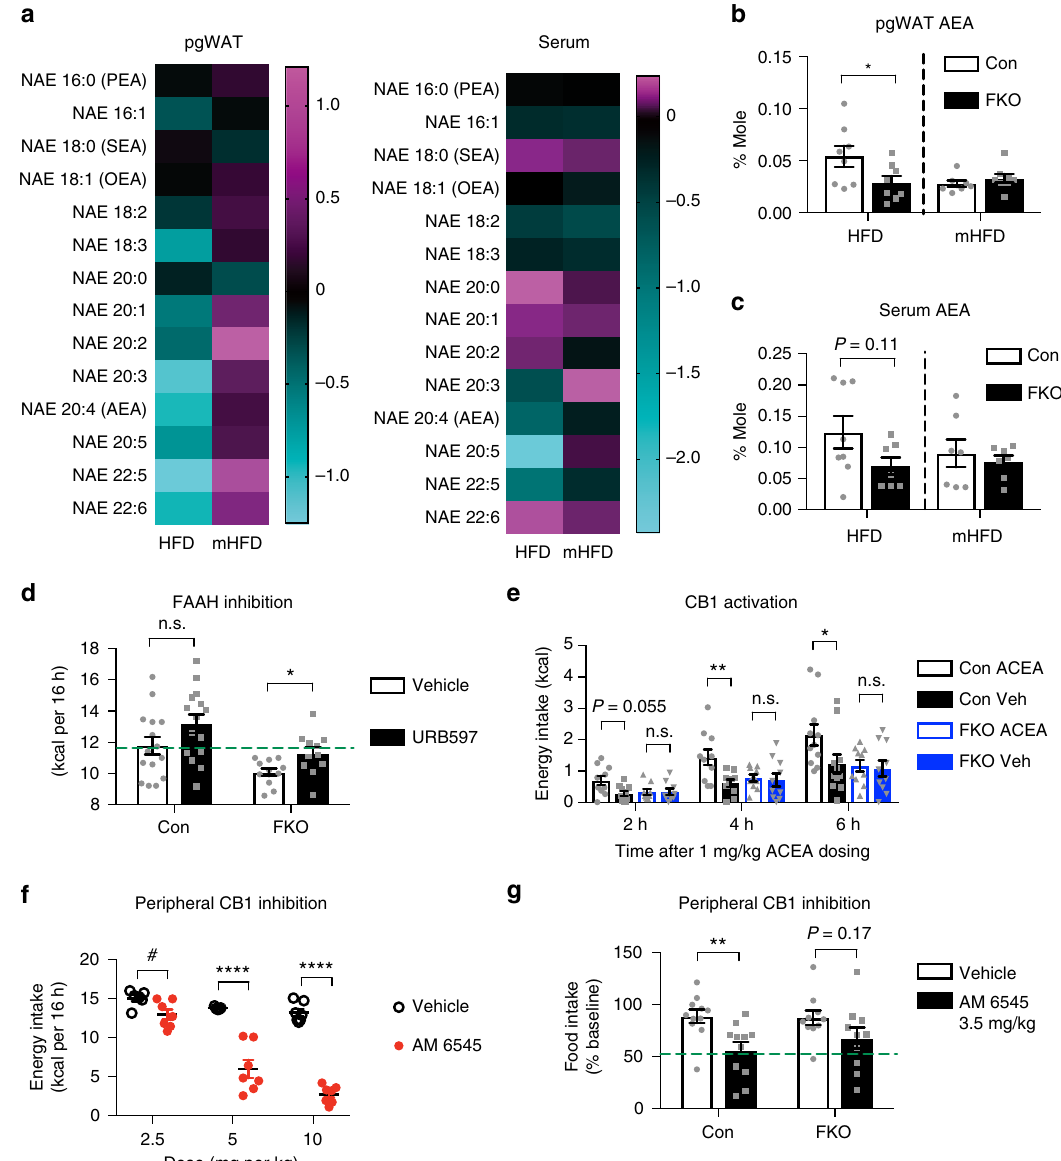
Fig. 5 Adipose tissue endocannabinoid metabolism mediates the appetite-inducing effect of OGT. a Heatmap of N -acylethanolamine (NAE) pro fi les in adipose tissue (pgWAT) and serum from mice ( n = 8 per group) fed HFD or mHFD for 14 – 15 weeks. Data has been processed to follow Gaussian distribution. Each box represents the log 2 ratio of FKO/WT. b , c Levels of AEA in adipose tissue ( b ) and serum ( c ) from mice described above. d Energy intake of mice ( n = 15 or 11) fed HFD for 10 – 13 weeks and dosed with FAAH inhibitor URB597 (0.5 mg/kg). n.s. not signi fi cant, * P < 0.05, multiple t-tests adjusted by the Holm – Sidak method. e Energy intake of mice ( n = 11 or 10) fed HFD for 12 – 14 weeks and dosed with CB1 agonist ACEA (1 mg/kg). Mice were dosed at 8:30 – 9:00 a.m., and measured at indicated time points. n.s. not signi fi cant, * P < 0.05, ** P < 0.01, repeat-measure post hoc Sidak ’ s tests. f Energy intake of mice ( n = 7 per group) fed HFD for 13 weeks dosed with peripheral CB1 receptor blocker AM 6545 as indicated. Data were presented as mean ± s.e.m. n.s. not signi fi cant, * P < 0.05, ** P < 0.01, **** P < 0.0001, post hoc Sidak ’ s tests, or # P < 0.05, two-tailed Student ’ s t-test. g Food intake (% pre-injection baseline) of mice ( n = 11 or 10) fed HFD for 10 – 11 weeks and dosed with CB1 antagonist AM 6545 (3.5 mg/kg). ** P < 0.01, repeat-measure post hoc Sidak ’ s tests. A dashed line in ( b , c ) indicates that data from HFD study and mHFD study are presented in a side-by-side manner, and